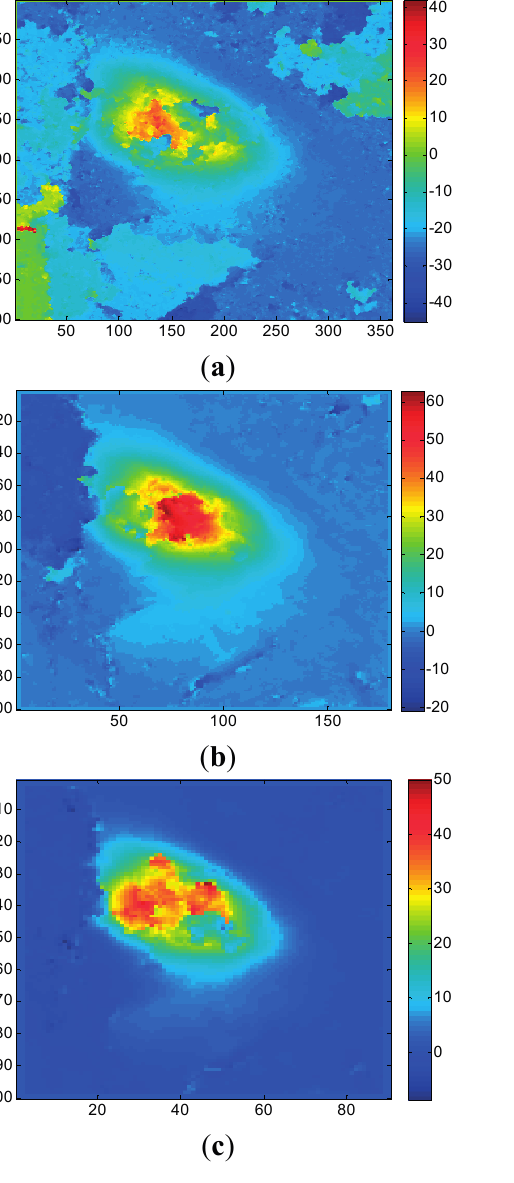
Figure 3. Unwrapped maps (left) and rewrapped maps (right) under different numbers of multi-looks: ( a ) unwrapped map of 1 × 1 look; ( b ) unwrapped map of 2 × 2 looks; ( c ) unwrapped map of 4 × 4 looks; ( d ) rewrapped map of 1 × 1 look; ( e ) rewrapped map of 2 × 2 looks; ( f ) rewrapped map of 4 × 4